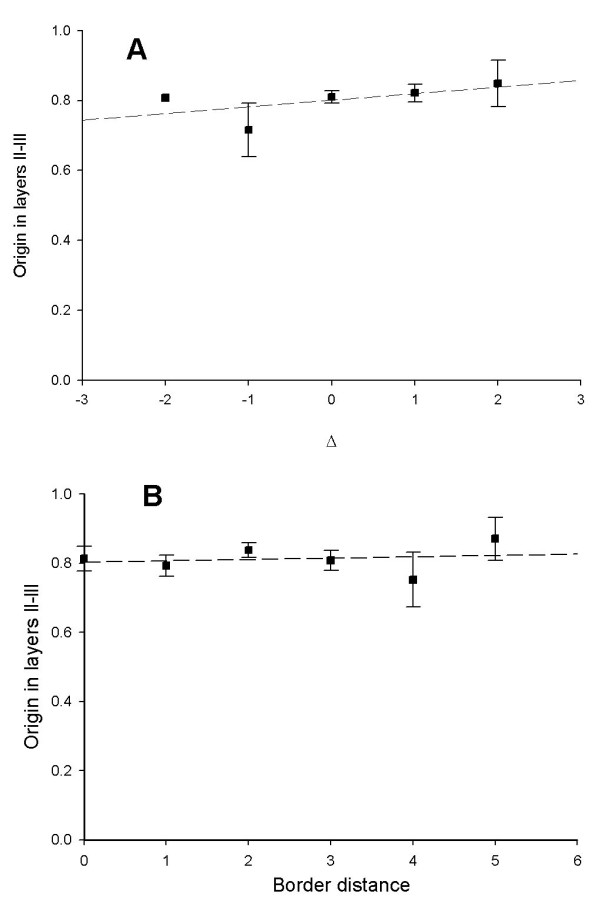
Comparison of the relationship of laminar origin of contralateral projection neurons to structural type and border distance. (A) The x-axis represents the type level difference, Δ), calculated as level (projection origin) – level (projection target, that is, injection site). Normalized origins of contralateral projection neurons varied significantly with Δ (Spearman's ρ, = 0.70; p < 0.04). (B) The x-axis represents the border distance from the injection site on the contralateral side (Spearman's ρ, = -0.04, p > 0.91).